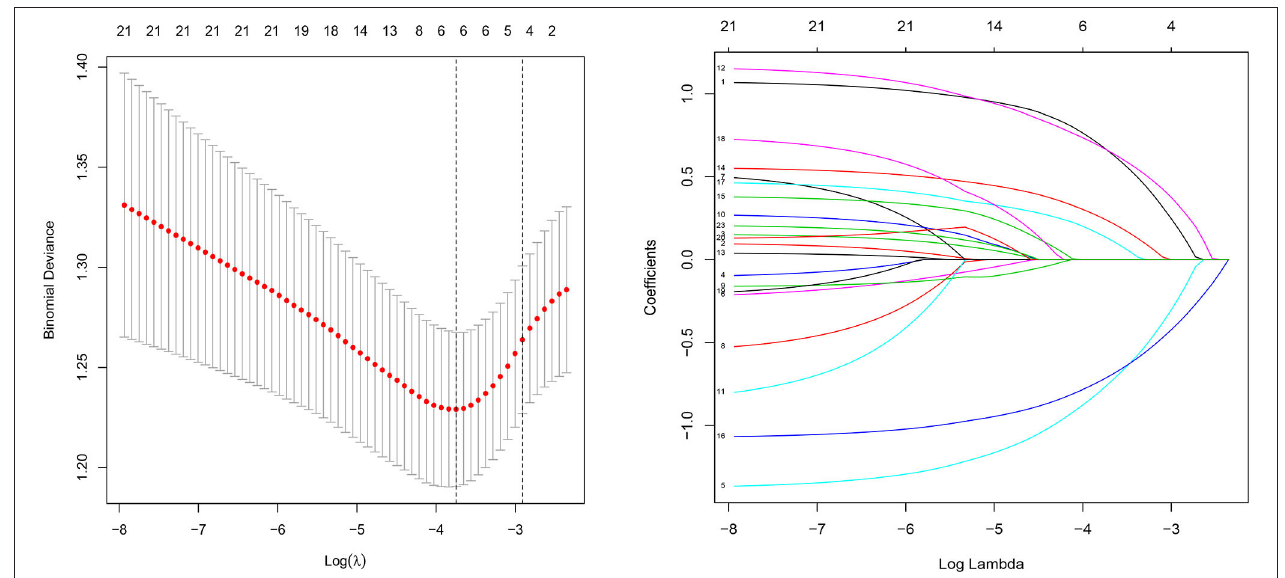
FIGURE 1 | Demographic and clinical feature selection using the LASSO logistic regression model. LASSO, least absolute shrinkage and selection operator; SE, standard error.